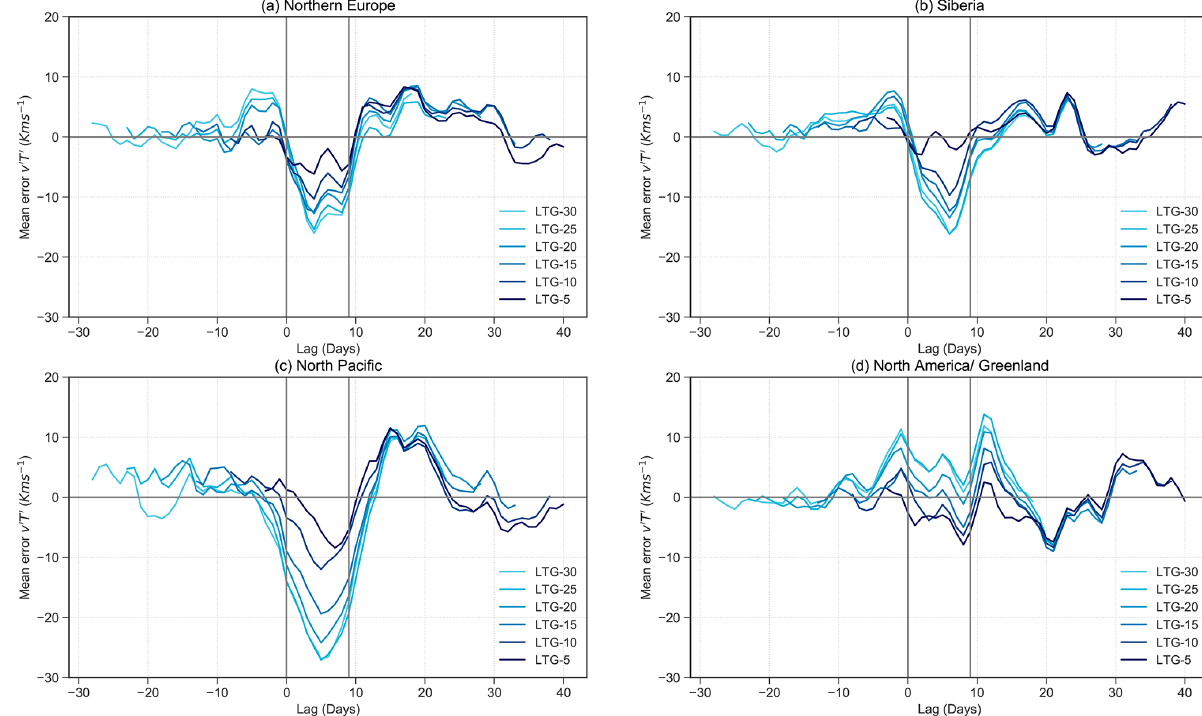
Figure A5. Mean error of the composite v (cid:48) T (cid:48) at 100hPa for decel- eration events over (a) northern Europe, (b) Siberia, (c) North Pa- cific and (d) North America/Greenland predicted by the hindcasts at different lead